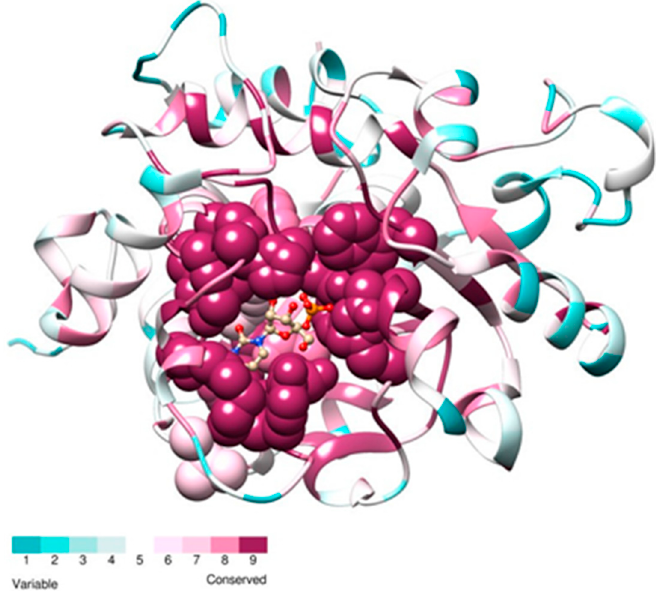
Figure 8. High sequence conservation near the binding site in ST6Gal. ST6Gal I and ST6Gal II show a high level of conservation in the region surrounding the ligand binding site. MSA were obtained using profile-profile mode with clustalX and 101 vertebrate ST6Gal I and ST6Gal II sequences (Data S3). Sequence conservation was calculated with ConSurf server, the result was mapped into the PDB structure 4JS1, a crystal structure of human β -galactoside α 2,6-sialyltransferase I (ST6Gal I) in a complex with cytidine (CTN) and phosphate (PO 4 ). The structure is depicted in cartoon, colored by the conservation score. Ligand molecules are shown in ball and stick representation, residues at contact distance (<5 Å) from ligands are shown in sphere.